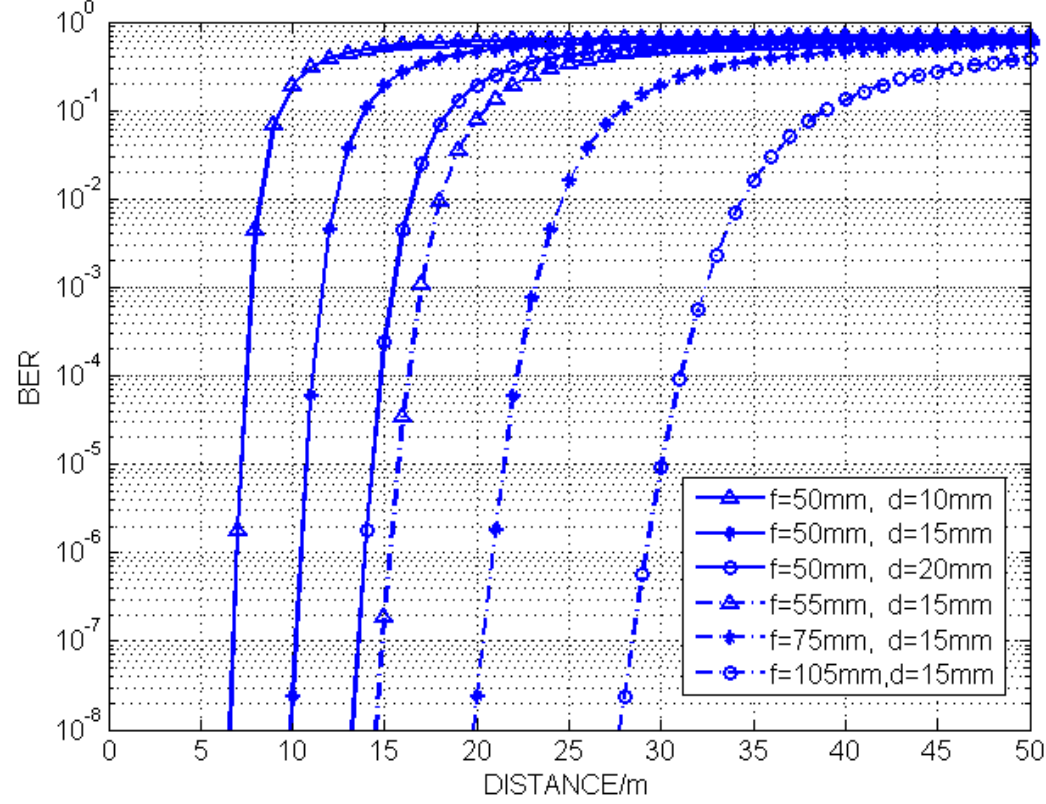
Figure 10. Bit error ratio performance of different communication